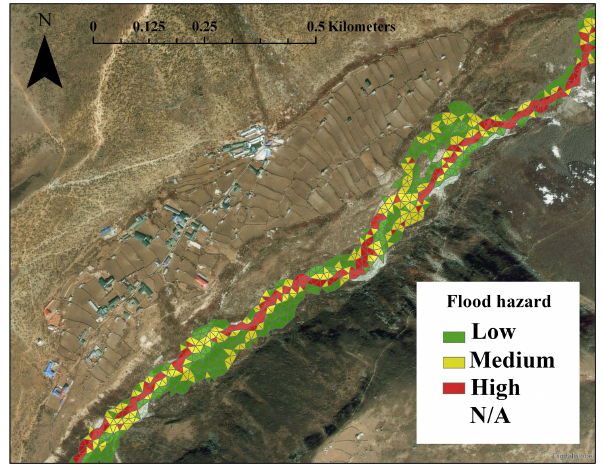
Figure 11. Hazard level at Dingboche for the 2045 large avalanche, MPM